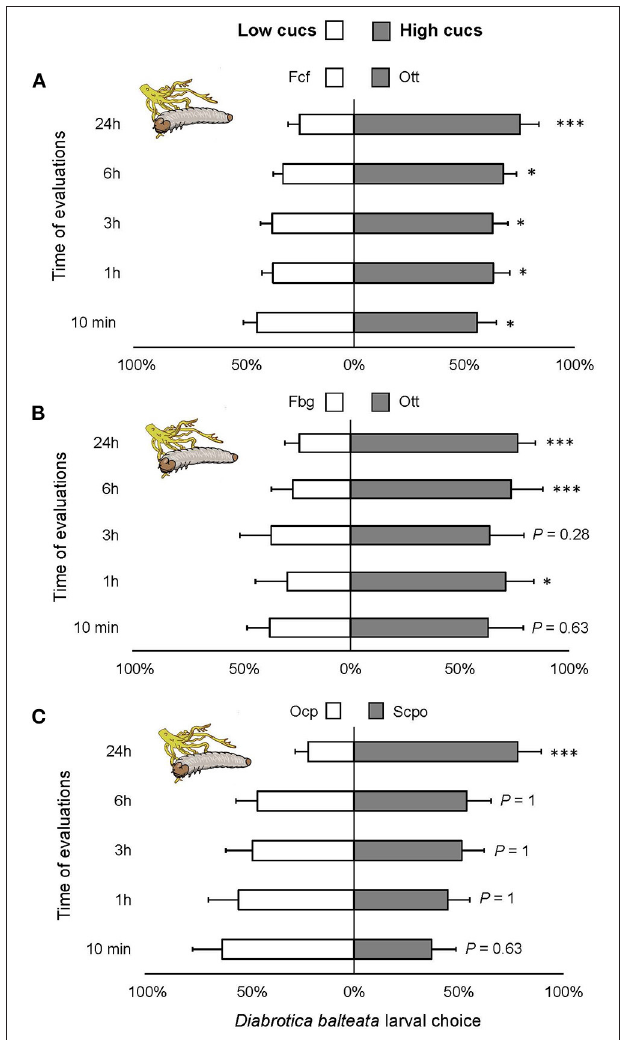
FIGURE 5 | Feeding preference of Diabrotica balteata larvae on roots of domesticated varieties of squash with high cucurbitacin content. (A–C) Five larvae of D. balteata were allowed to choose between two varieties with low and high levels of cucurbitacins. Larval choice was recorded as number of larvae on roots after 10min, 1, 3, 6, and 24h after the start of the experiment. Sample sizes: (A) n = 30, (B,C) n = 10. Bars represent means ( ± SE) express the percentage of larvae that chose a treatment per time point (x axis). Bonferroni corrected P -values are given for treatment comparisons [generalized linear model (family, Binomial)], followed by pairwise comparisons of Least Squares Means (LS means). * P < 0.05, *** P <